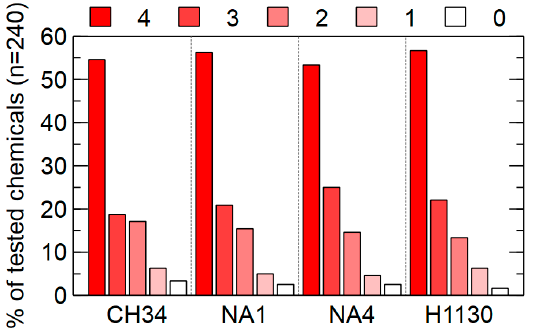
Figure 14. Percentage of tested chemicals (n = 240) to which C. metallidurans CH34, NA1, NA4 and H1130 are resistant. Four increasing concentrations are included in the phenotypic microarrays (0: susceptible to the lowest concentration, 1 to 4: resistant to the lowest up to the highest concentration).